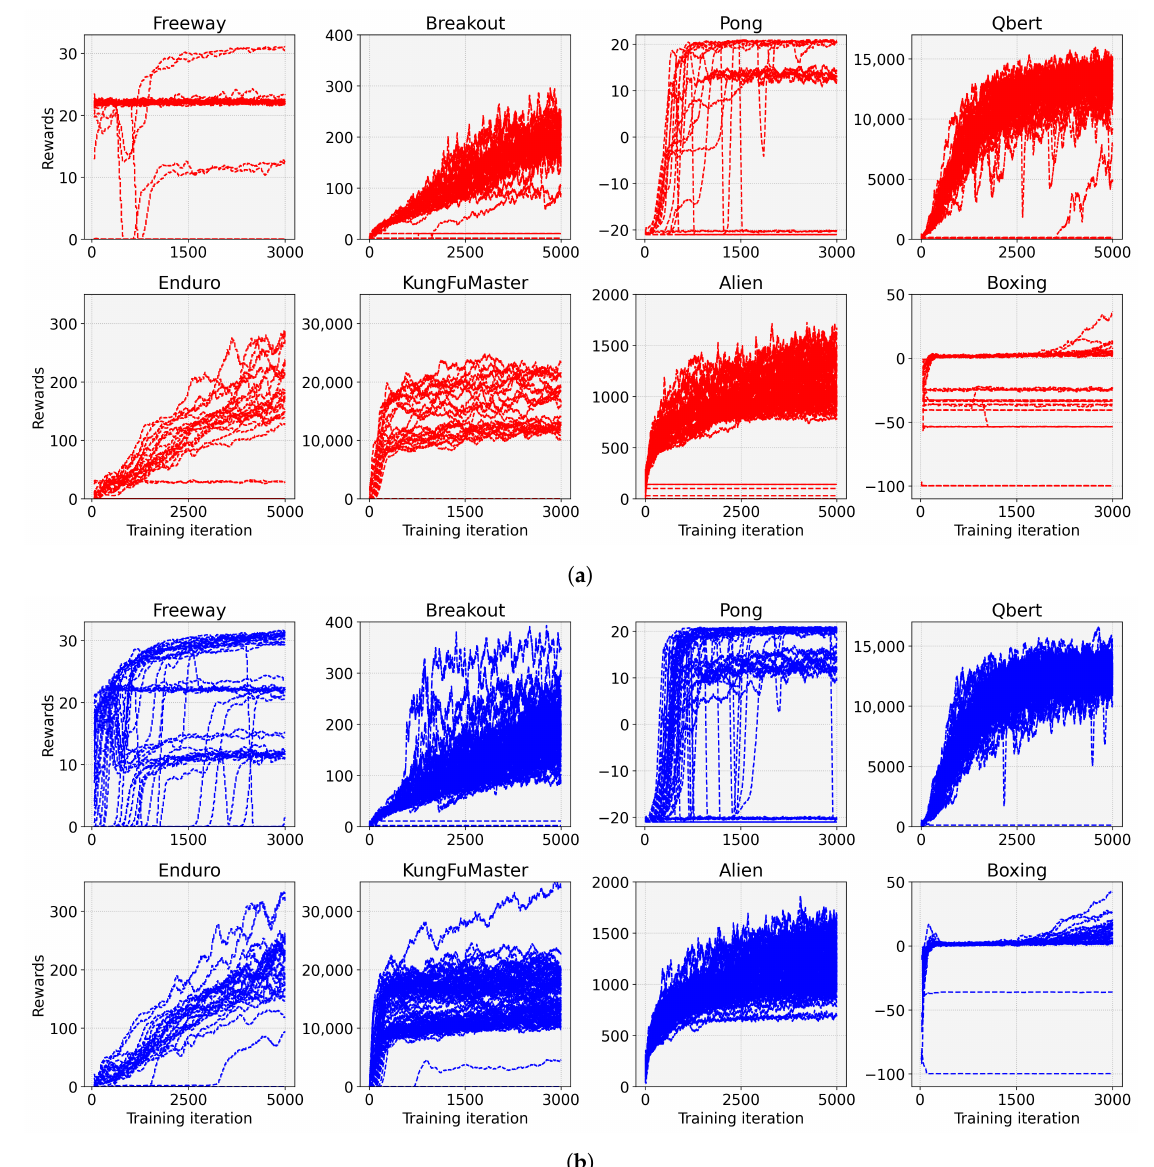
Figure 6. Learning curves for 50 individual experiments of ( a ) the conventional PPO and ( b ) the proposed entropy-aware model initialization-based PPO for 8 tasks. ( a ) default; ( b ) proposed.